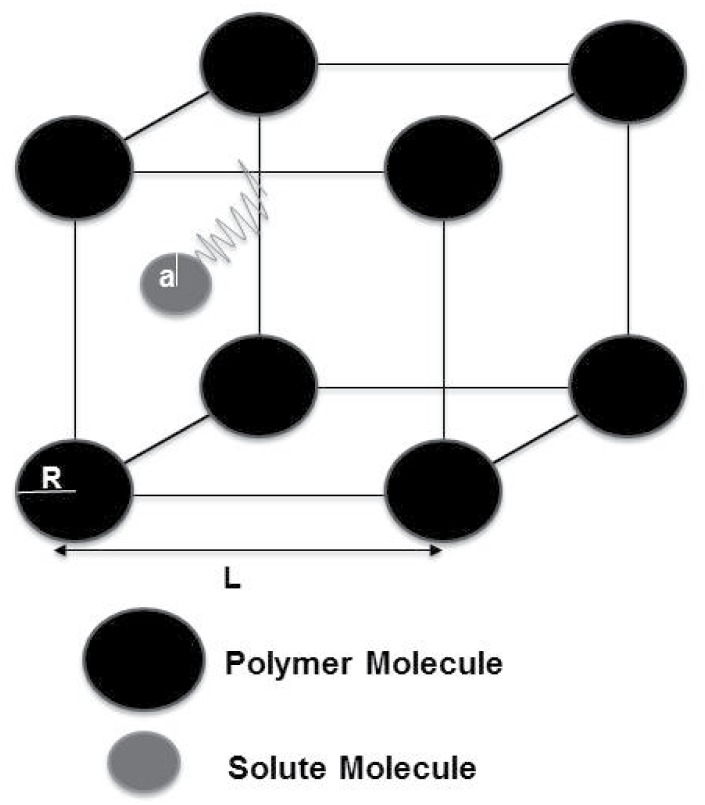
Microscopic model.